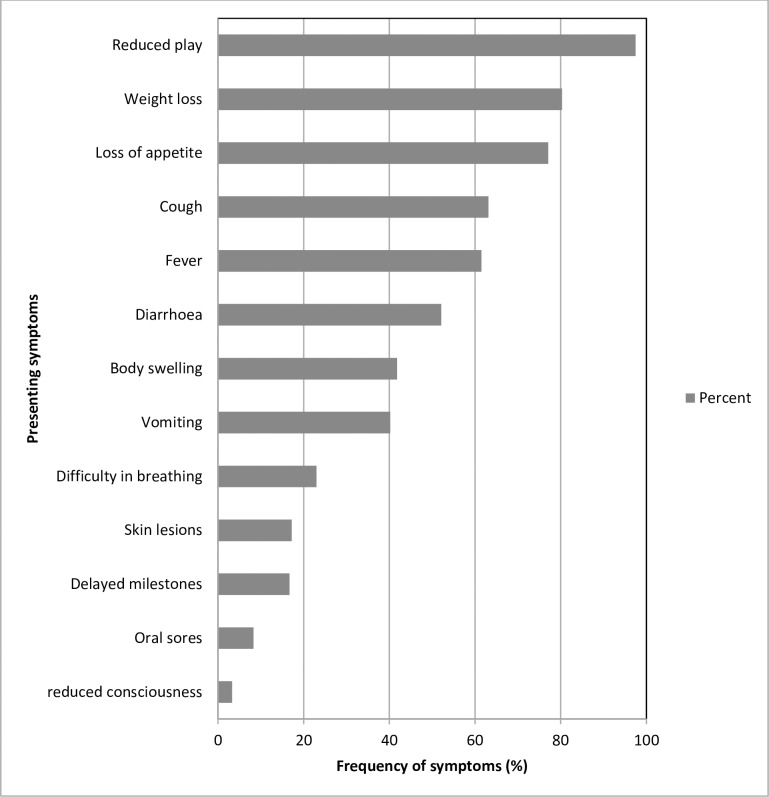
Presenting symptoms of the participants at admission.